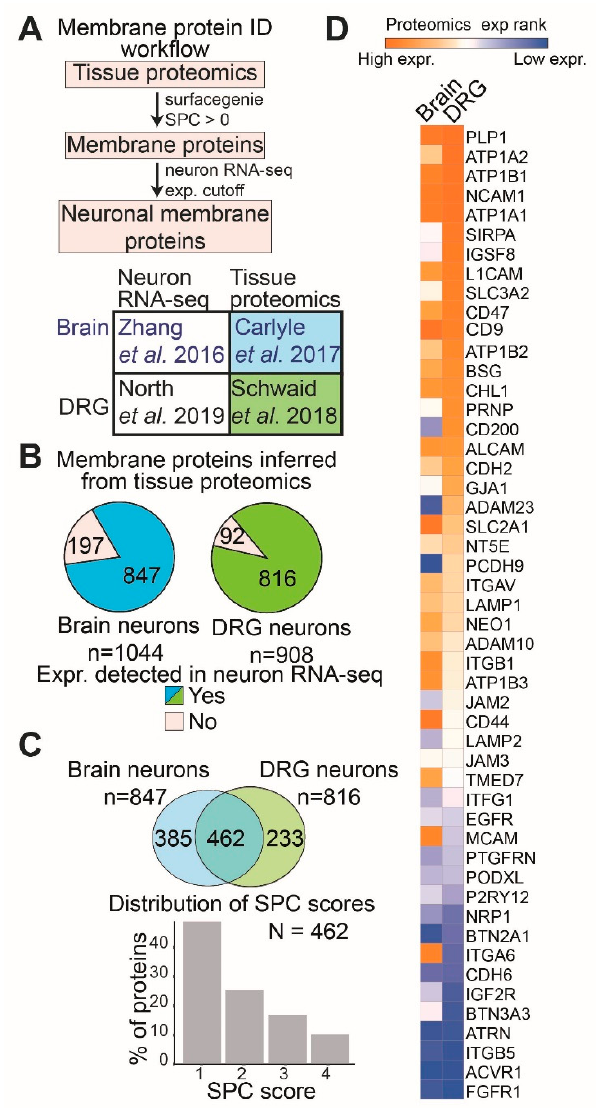
Figure 1. Analysis of human tissue proteomics and neural RNA sequencing data reveals several membrane proteins expressed in both brain and DRG neurons. ( A ) Pipeline for analysis (top) and the datasets used for brain [14,17] and DRG [15,16] neuron inferred membrane proteome analysis (bottom). ( B ) Pie charts representing all the membrane proteins (SurfaceGenie SPC score ≥ 1) identified from the human brain and DRG tissue proteomics. The pie section in green (brain), and blue (DRG) represents a protein with a more than median gene expression (expr.) in brain- or DRG-specific neuronal RNA sequencing. ( C ) Venn diagram comparing the inferred brain and DRG neuronal membrane proteome (top). Bar plot showing the distribution of SurfaceGenie SPC scores for the proteins common to both brain and DRG neuronal membrane proteome. ( D ) Heatmap of the brain and DRG tissue proteomics ranked expression (expr.) of high-confidence (SPC score ≥ 3) surface proteins common to both brain and DRG neuronal membrane proteome. All proteins and their ranks are listed in Table S1.